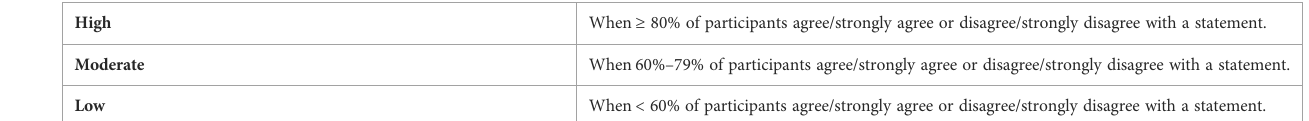
TABLE 1 Level of